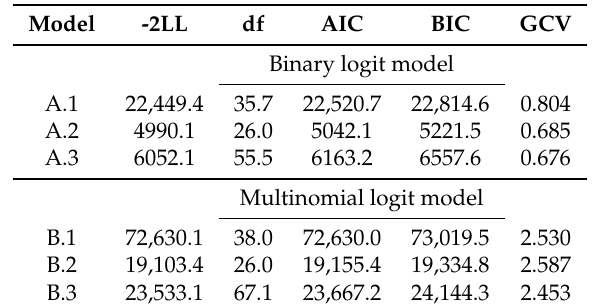
Table 5. Model comparison values based on Akaike Information Criterion (AIC) and on Bayesian Information Criterion (BIC) for the three specified models together with the marginal log-likelihood (LL) and Generalized cross